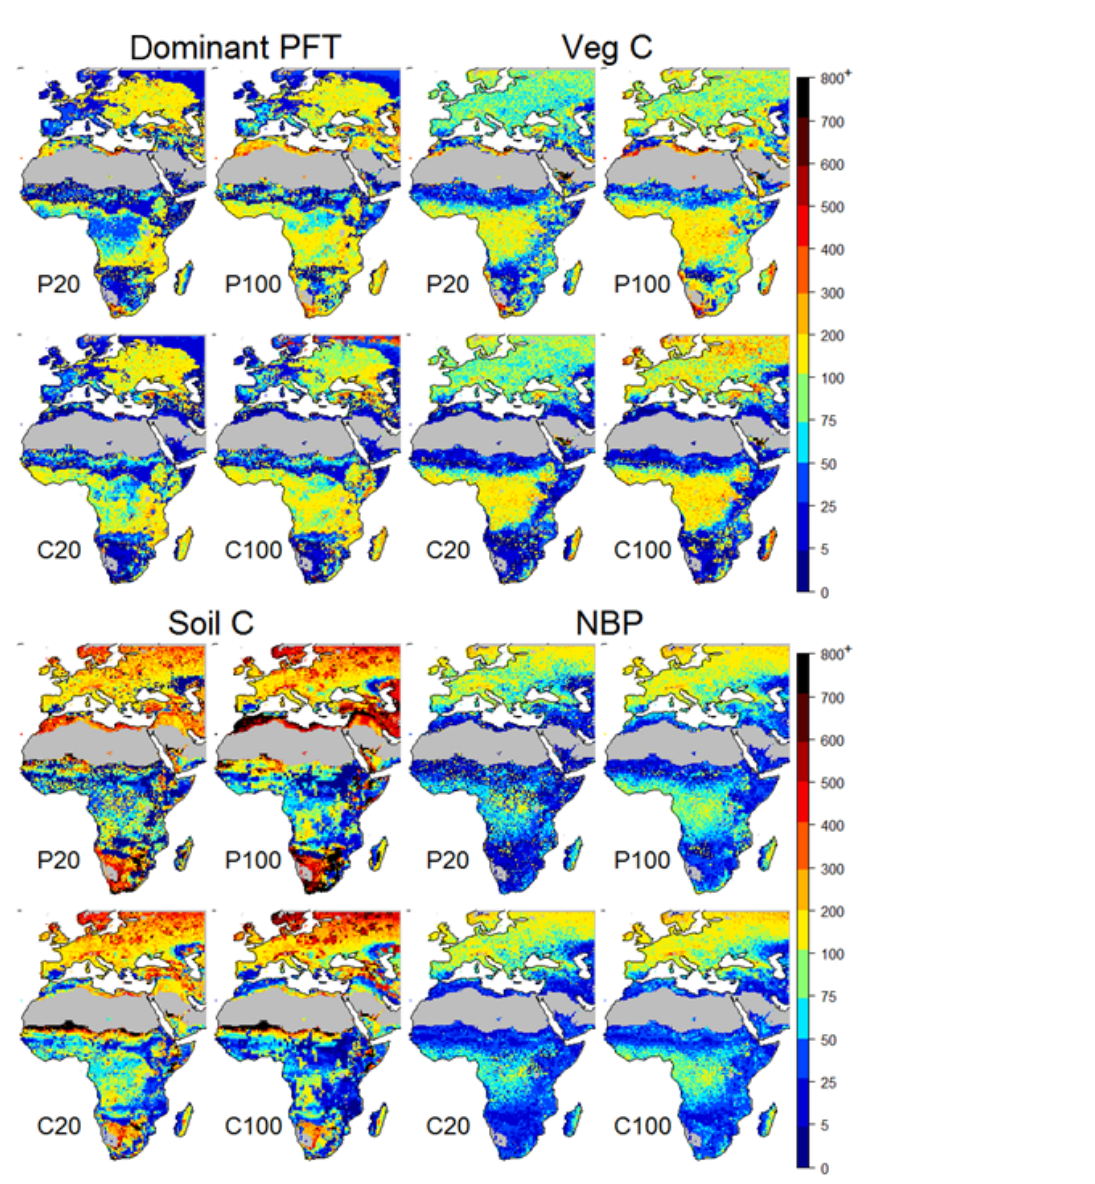
Figure 3. Maps of recovery times in years for the dominant PFT, vegetation C, soil C, and NBP for the P20, P100, C20, and C100